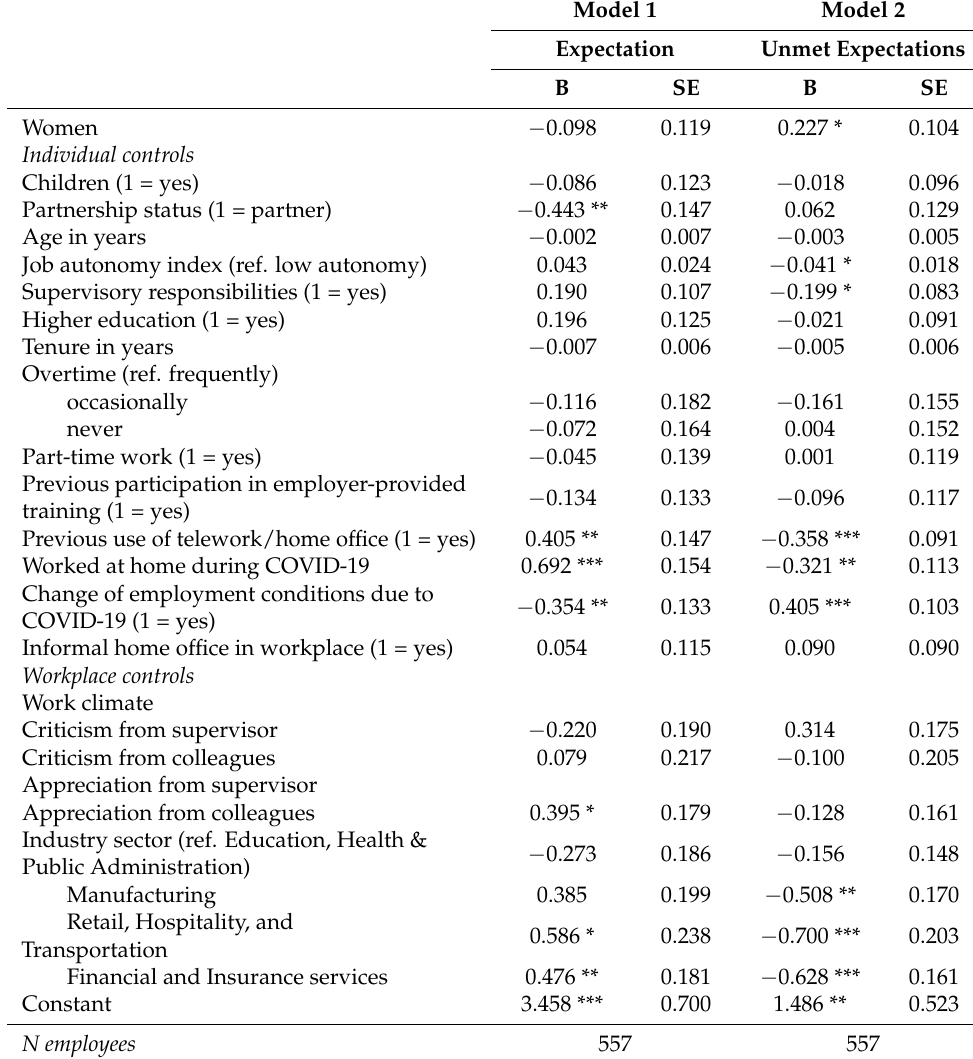
Table 3. The results of linear regression models, estimating the association of individual- and workplace-level characteristics regarding the expectation to be provided with training (Model 1) and unmet expectations (Model